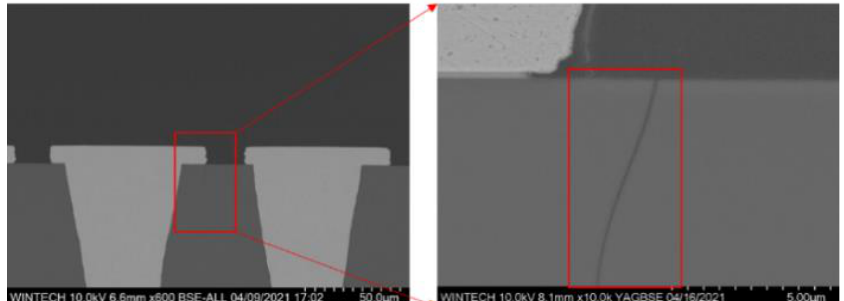
Figure 2. TGV package failure mode after temperature cycling.